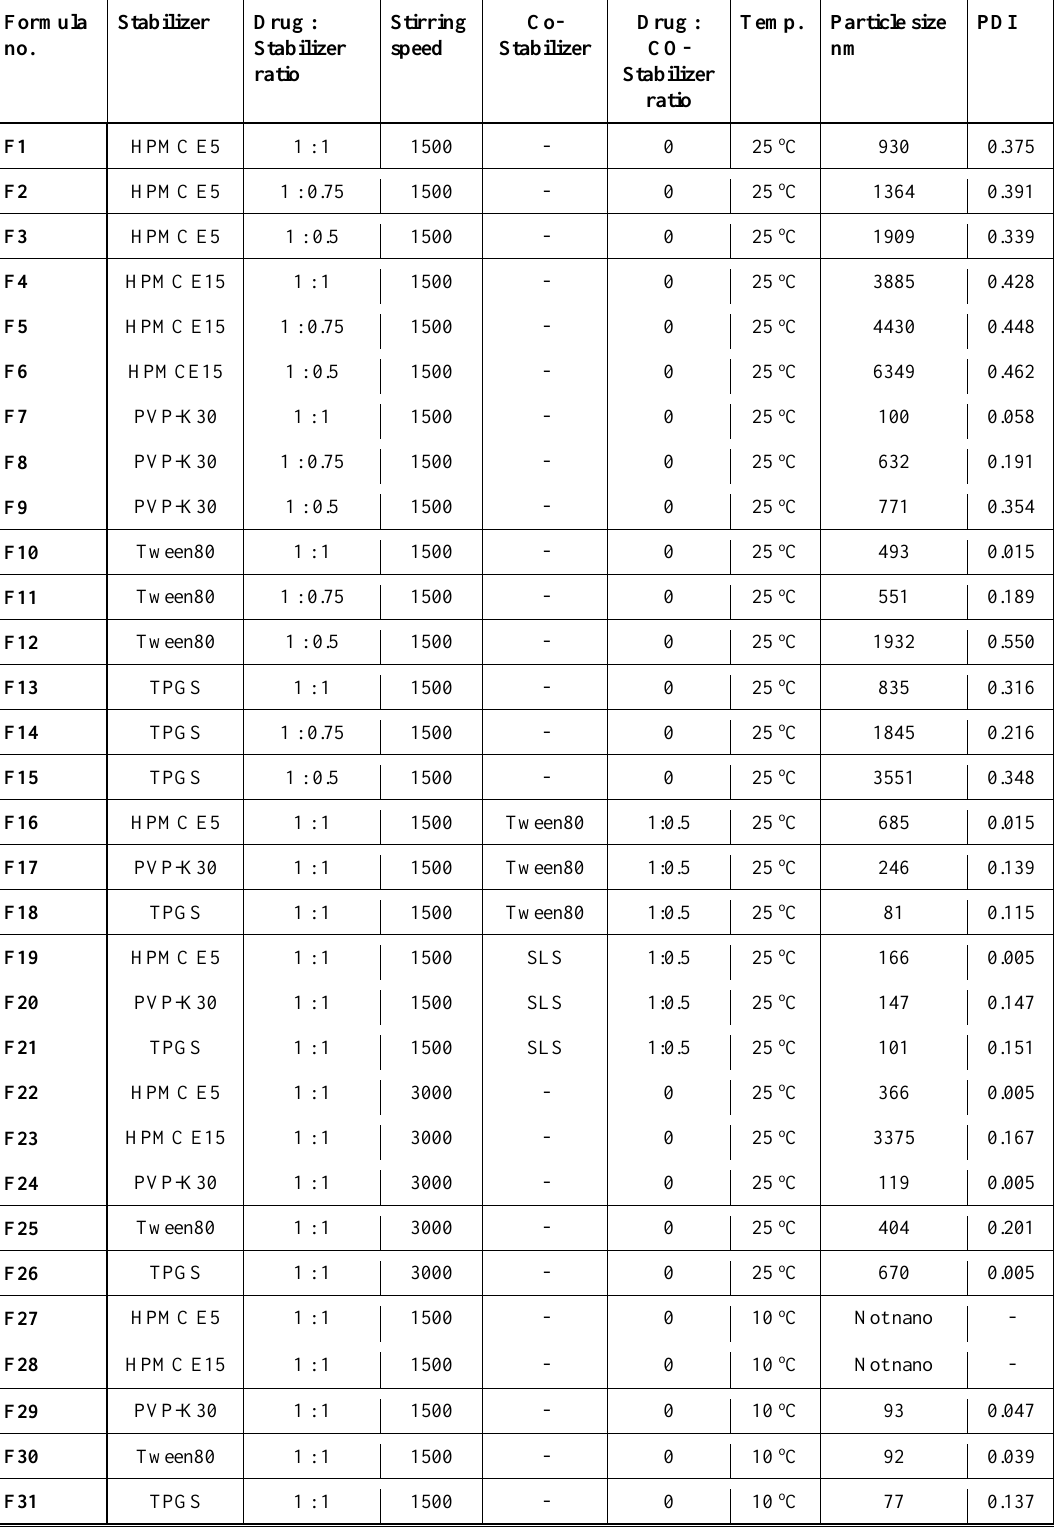
Table 1. Nanosuspension formulations prepared by solvent-antisolvent precipitation under